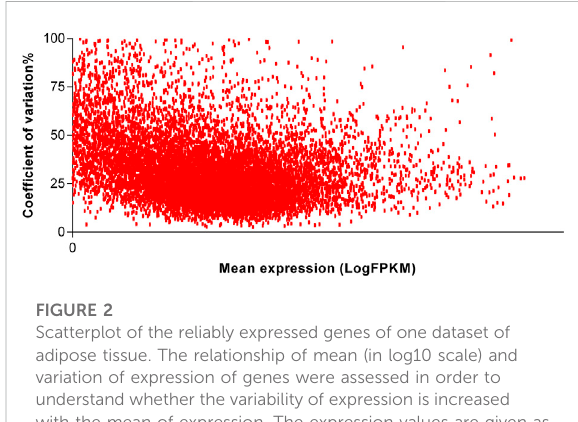
FIGURE 2 Scatterplot of the reliably expressed genes of one dataset of adipose tissue. The relationship of mean (in log10 scale) and variation of expression of genes were assessed in order to understand whether the variability of expression is increased with the mean of expression. The expression values are given as fragments per kilobase of transcript per million reads in log10